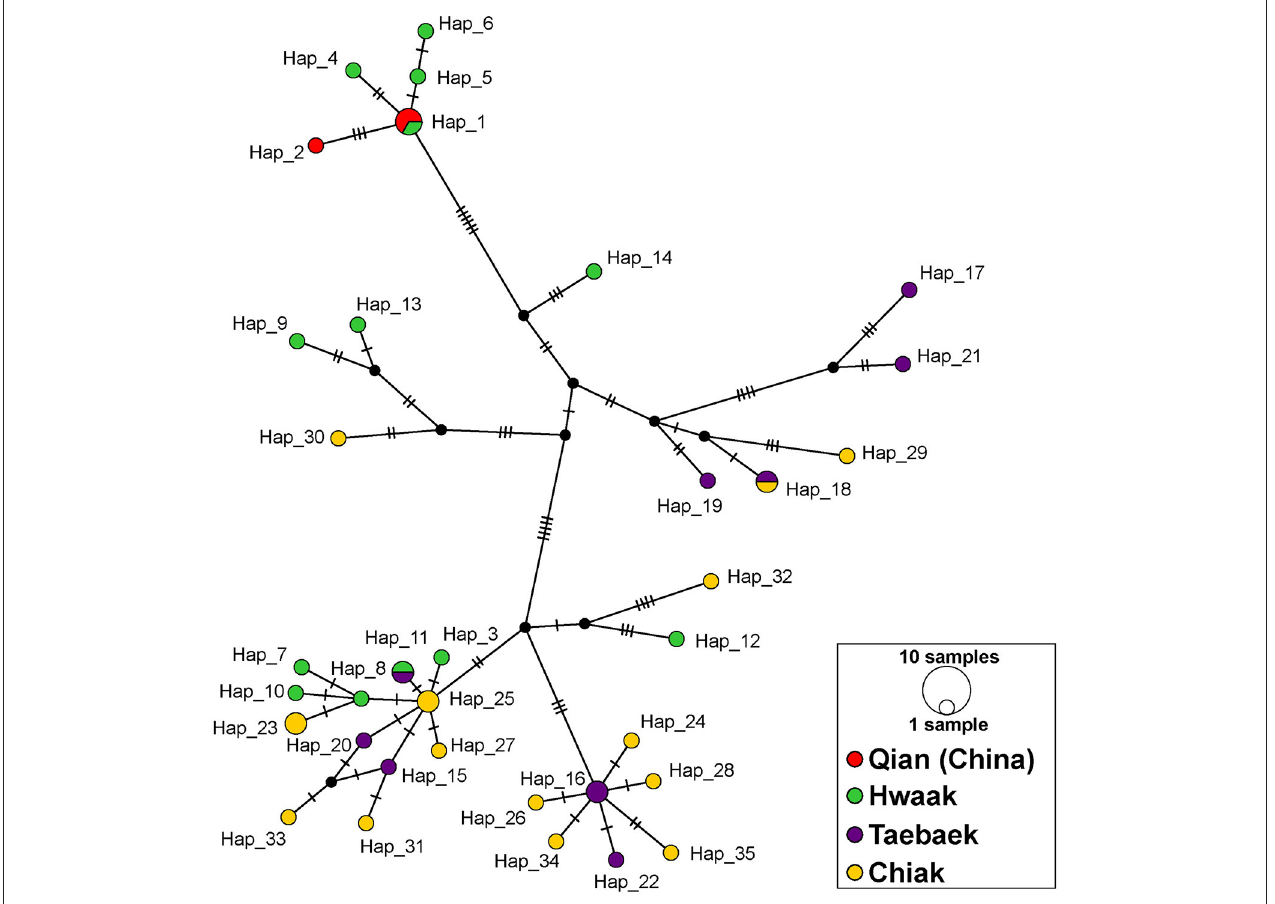
FIGURE 3 | Median-joining network of Bufo stejnegeri haplotypes based on a concatenated ND2 - ND3 dataset constructed in PopART. Haplotypes are represented by circles, whose sizes are proportional to the number of individuals. Different colors represent different mountain ranges, and potentially different populations. The color scheme is the same as in Figure 1 . Hatch marks correspond to nucleotide substitutions, while missing haplotypes are indicated by small black circles.